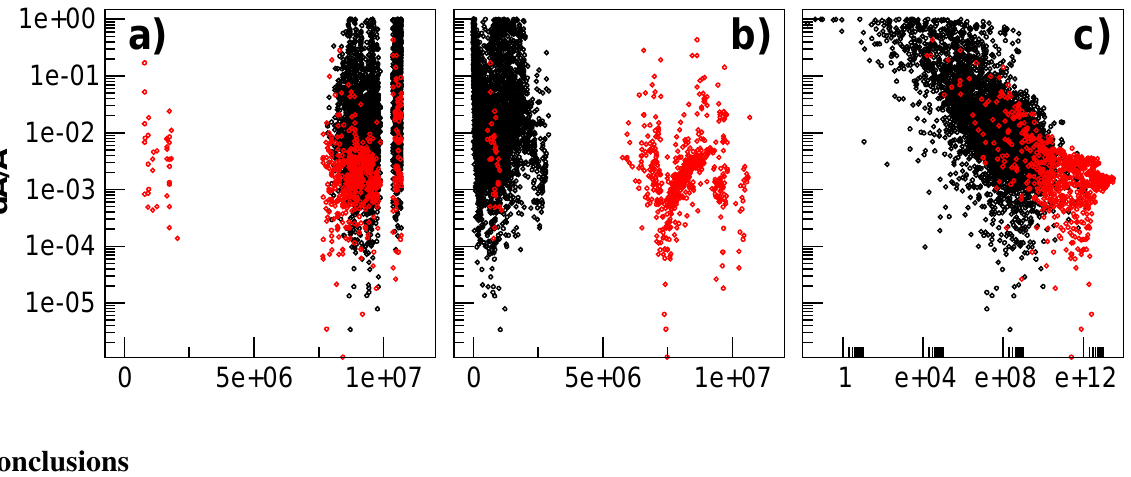
Figure 4. Uncertainty estimate (cid:14)A=A plotted against calculated excitation energies of upper levels ( a ); calculated transition energies ( b ) and calculated transition rates ( c ) for 4637 LS -allowed E1 transitions in carbon-like Fe XXI. Data points in red indicate transitions where the lower level belongs to the lower energy structure of Fe XXI. See text for